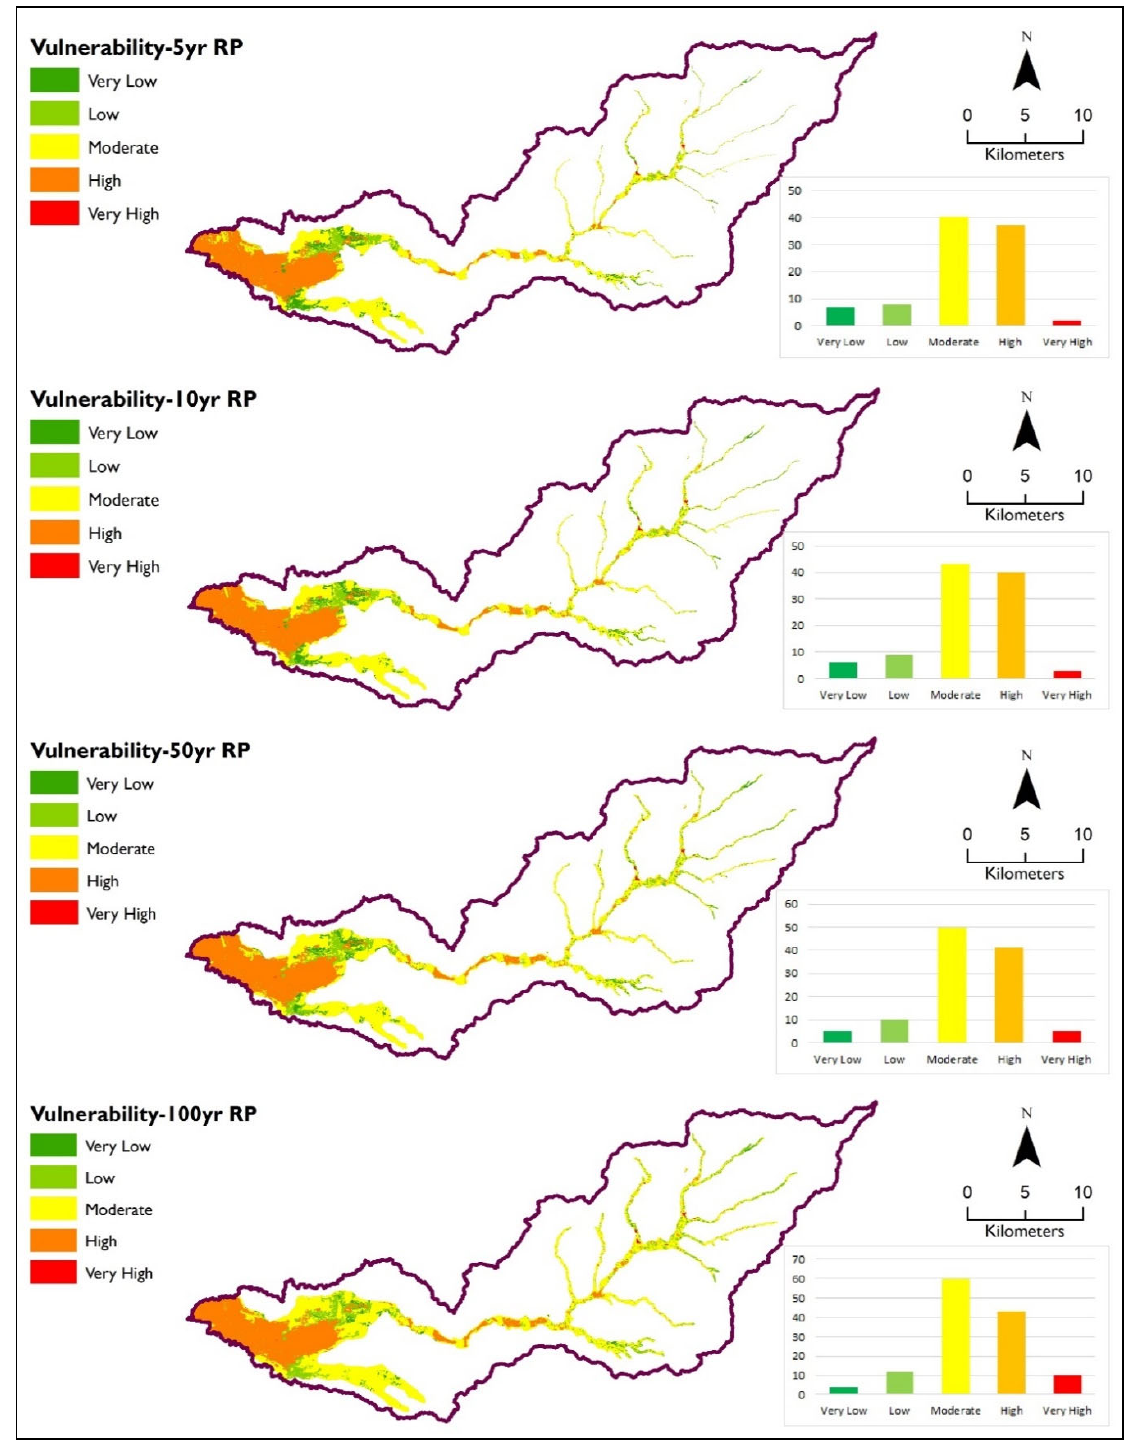
Figure 9. Flood Vulnerability Maps for different return